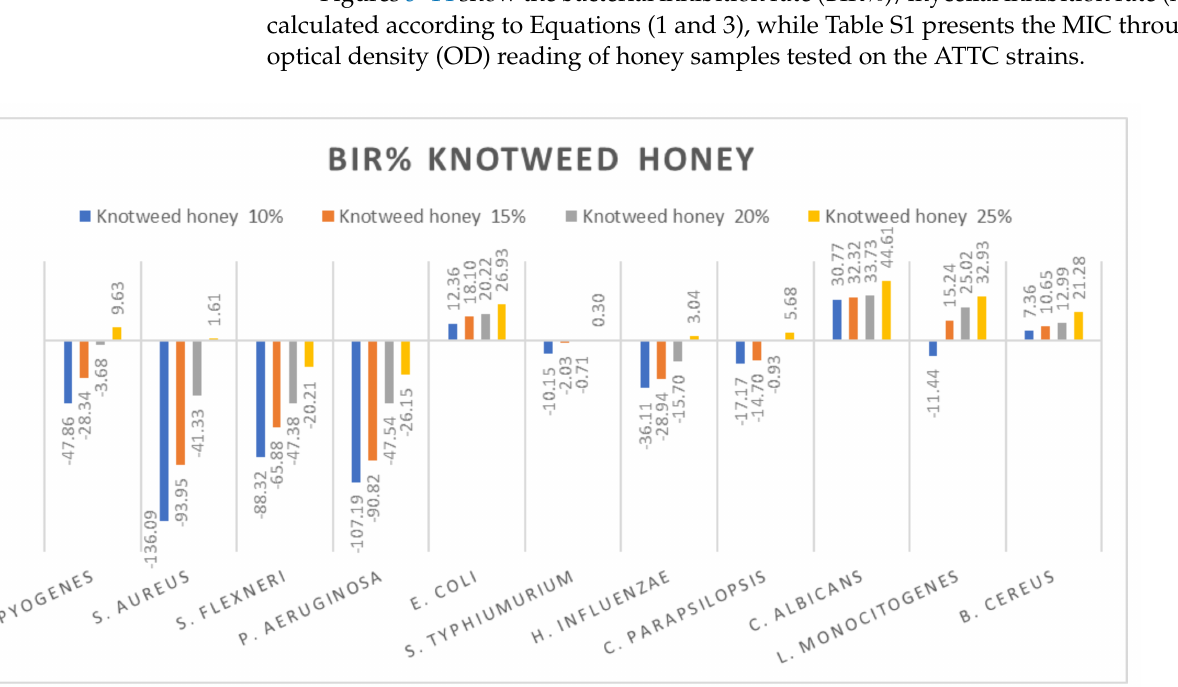
Figure 5. Knotweed honey antimicrobial activity (expressed as BIR%/MIR%) on